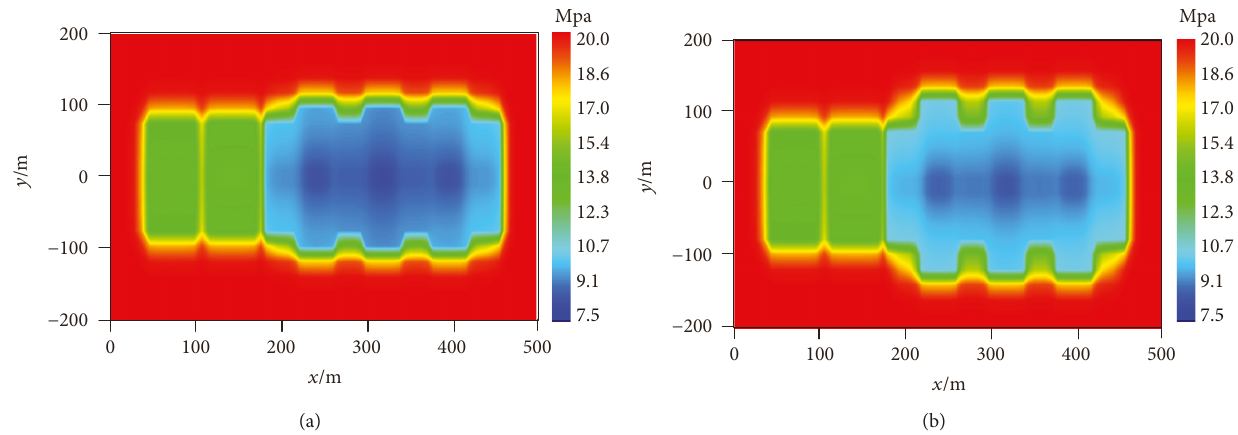
Figure 12: Reservoir pressure distribution: (a) 90 m hydraulic fracture half-length and (b) 110m hydraulic fracture half-length.